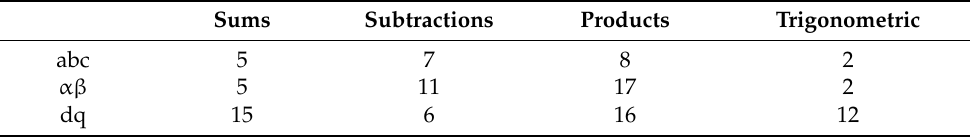
Table 6. Computational effort based on the number of algebraic and trigonometric operations.